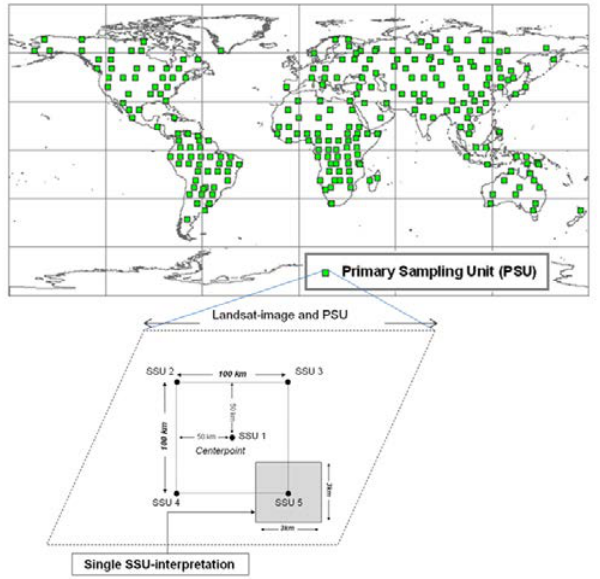
Figure 1. Sampling design for primary (PSU) and secondary samples (SSU) for the GLC2000 reference